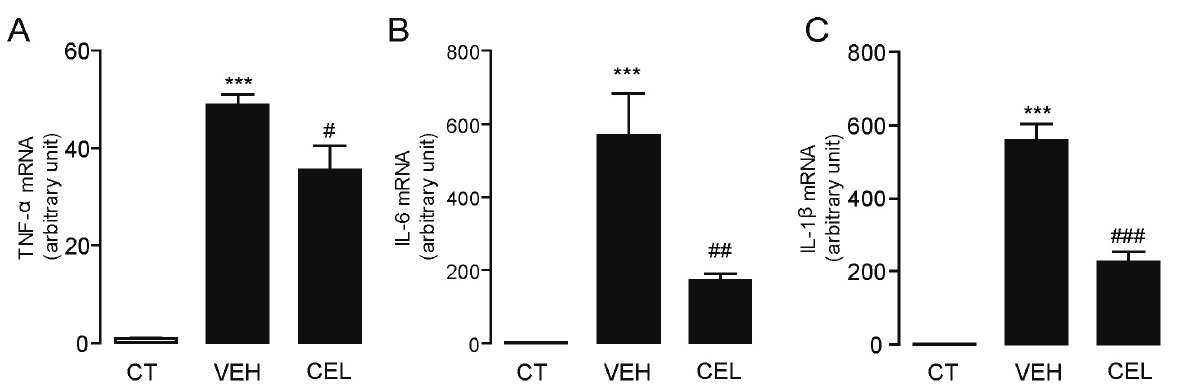
Figure 3. Celastrol suppressed carrageenan-induced inflammation. The effect of vehicle (VEH, 5% PEG/5% Tween-80 in saline, 10 mL/kg, i.p.) and celastrol (CEL, 0.3 mg/kg, 10 mL/kg, i.p.) on the mRNA expressions of ( A ) TNF- α ; ( B ) IL-6; and ( C ) IL-1 β in the paw tissues of carrageenan injected mice (close bars). *** p < 0.001 vs. non-carrageenan injection (CT, open bars); # p < 0.05, ## p < 0.01, ### p < 0.001 vs. VEH, one-way ANOVA with Bonferroni’s multiple comparison test. n =